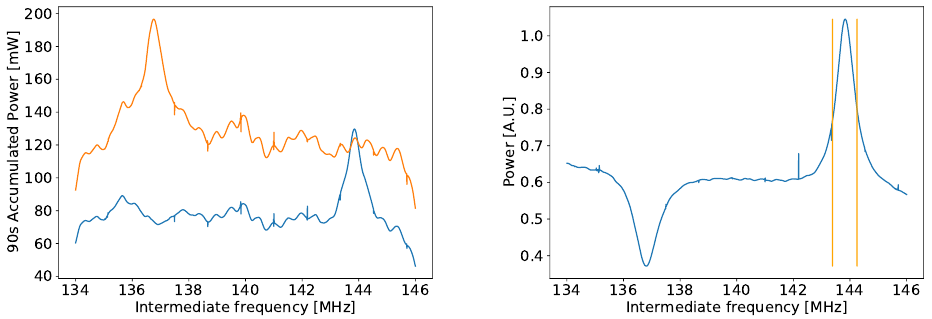
Figure 3 . Left: typical spectra for two different LO frequencies ( l 1 = 8 . 240 GHz and l 2 = 8 . 247 GHz ). Upon changing the LO frequency, the cavity resonance peak changes position in the IF frequency. The visible spikes in the spectra are noisy bins produced by the improper isolation between the ADC card and the FPGA. Right: an example of a δ d division of two spectra taken at two different LO frequencies. This procedure removes the wave-like structures originating from the electronics which are common to both spectra. The orange vertical lines represent the frequency range considered in the analysis which covers a region without noisy bins. The physical frequency (PF) of the input signal can be calculated using PF = IF + LO. We will label the spectra taken at the two different LO frequencies δ l 1